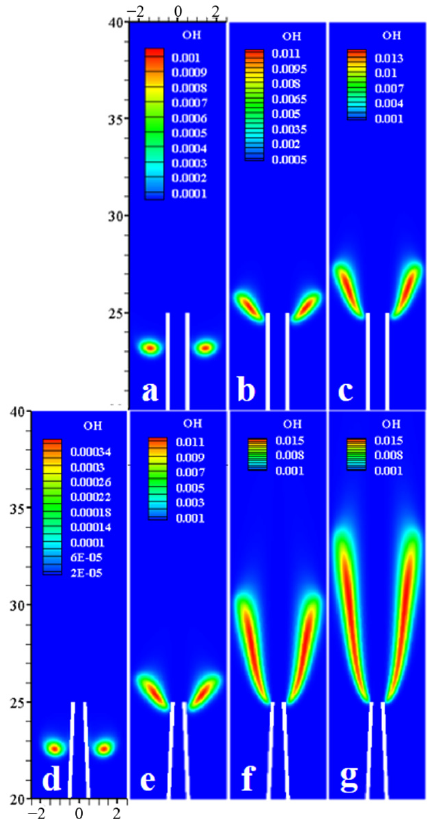
Figure 6. Contours of OH mass fraction at various jet velocities: ( a ) d = 0.8 mm, V f = 9 m/s; ( b ) d = 0.8 mm, V f = 25 m/s; ( c ) d = 0.8 mm, V f = 40 m/s; ( d ) d = 0.4 mm, V f = 3 m/s; ( e ) d = 0.4 mm, V f = 9 m/s; ( f ) d = 0.4 mm, V f = 25 m/s; ( g ) d = 0.4 mm, V f = 40 m/s.